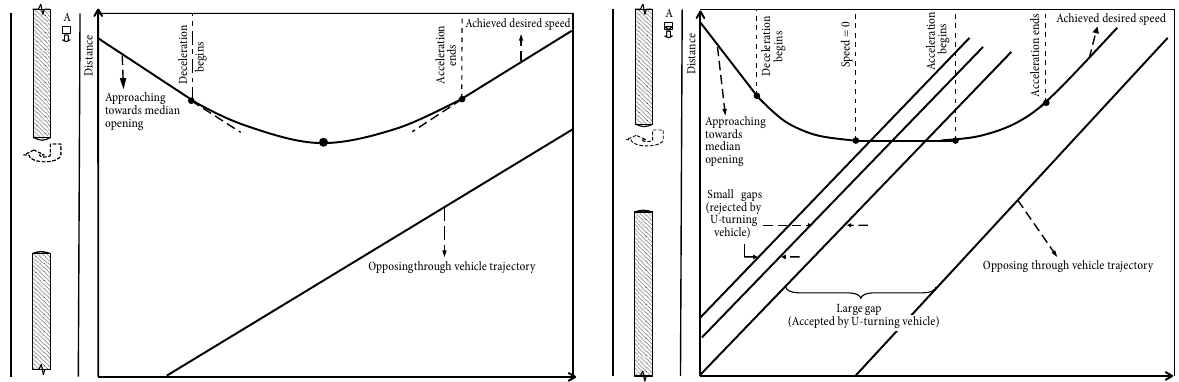
Fig. 3. Time–distance diagram for free merging Fig. 4. Time–distance diagram for SM